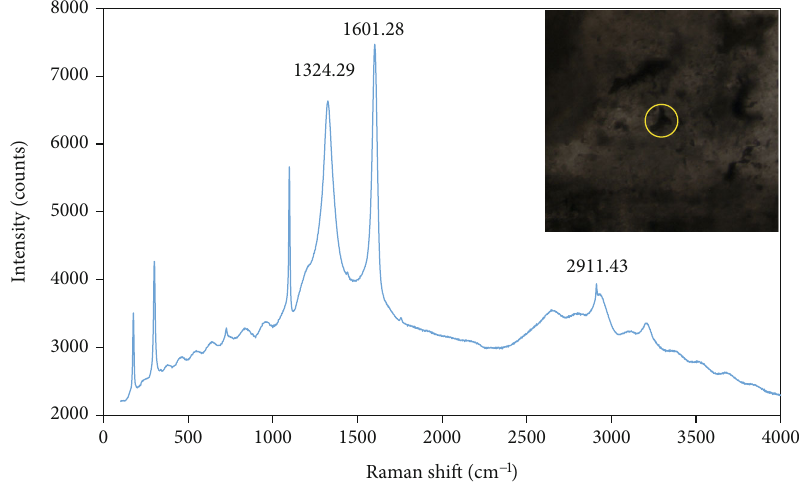
Figure 10: Raman for paleo-oil inclusion (solid bitumen:1324.29 and 1601.28+ CH4: 2911.43) from the Longwangmiao Formation of MX39 (4877.22